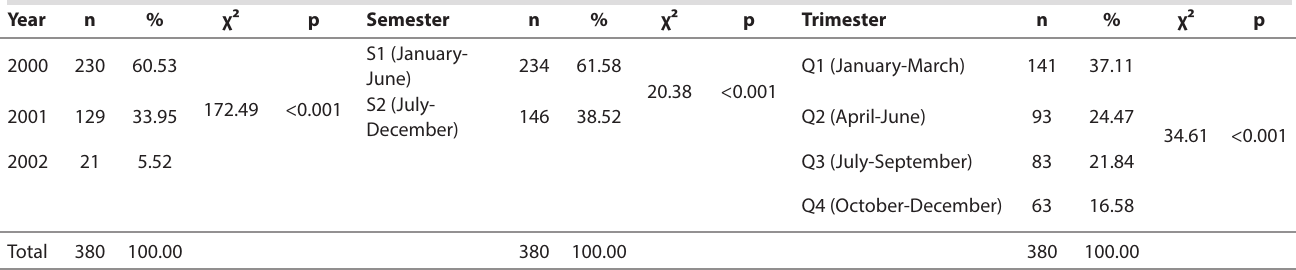
TABLE 2. Number and percentage distribution by birth year, semester, and trimester for the full sample